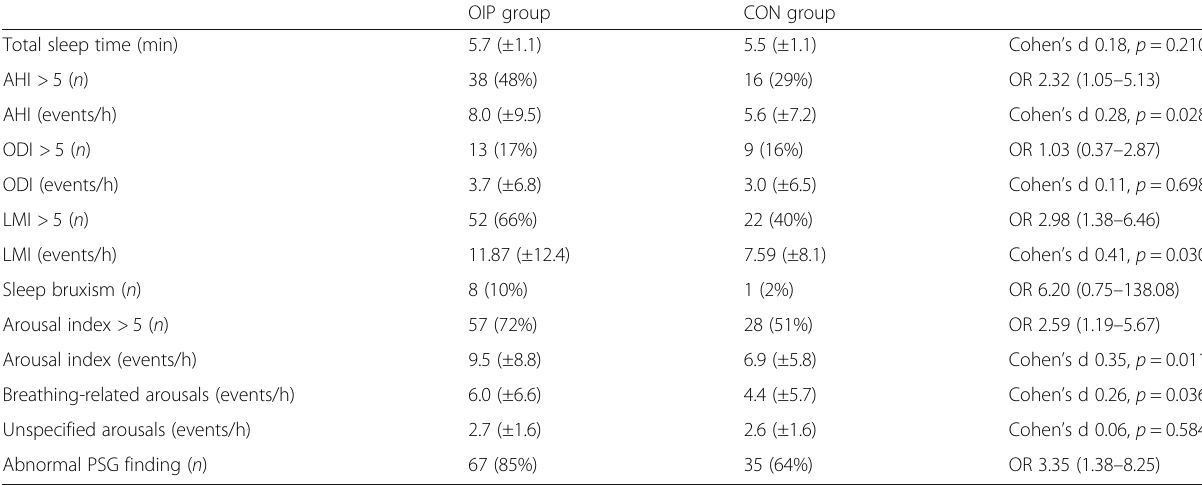
Table 1 Individuals with excessive daytime sleepiness or abnormal findings during the sleep study with full-night attended polysomnography